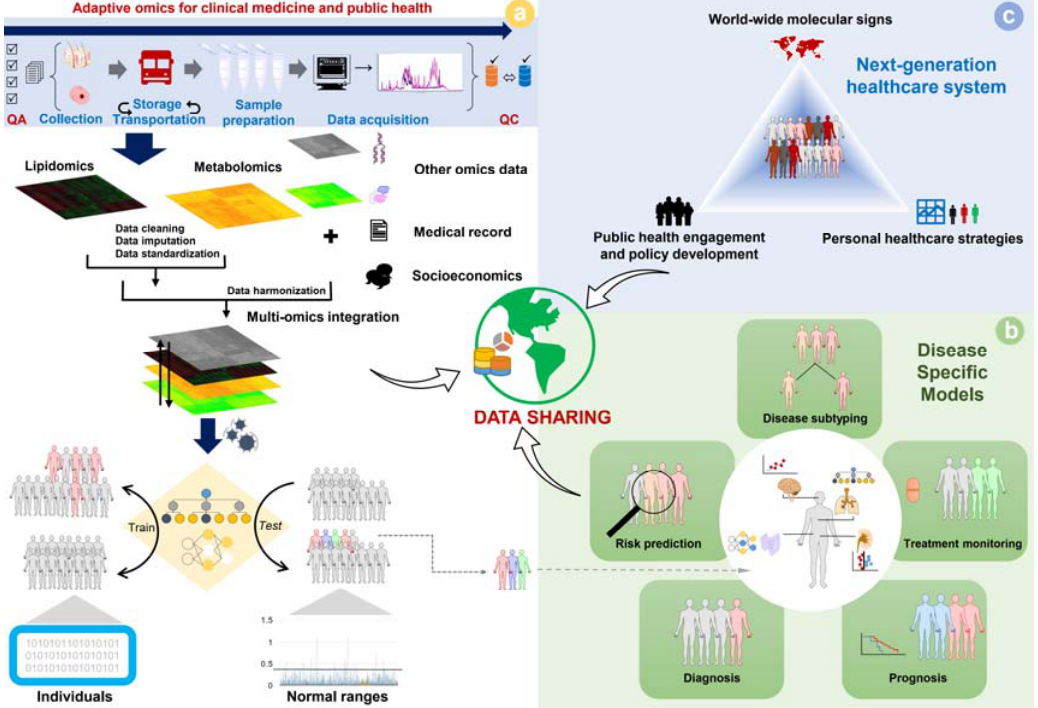
Figure 3. Metabolic phenotyping as a core member to establish multi-omics biosignatures for the development of the next-generation healthcare system: ( a ) adaptive workflow for a population-based study to determine the normal range of lipidome / metabolome, and detect nonspecifically abnormal conditions based on quantitative multi-omics profiles in reference to intrinsic, extrinsic, and socioeconomic factors; ( b ) corresponding models constructed for disease-specific purposes; ( c ) the next-generation healthcare system based on advances in smart engines with omics data as the primary pillar, and promoted by data sharing and machine learning.